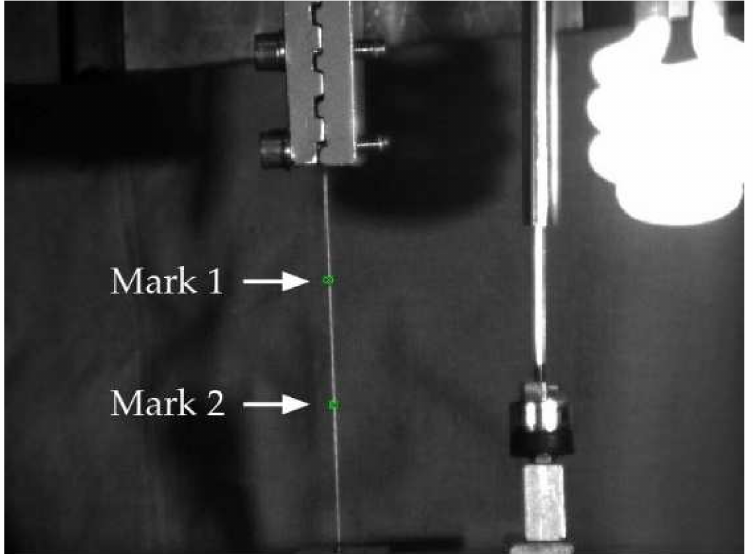
Figure A1. Videogrammetric image to record λ c between 2 ink marks in the suture central